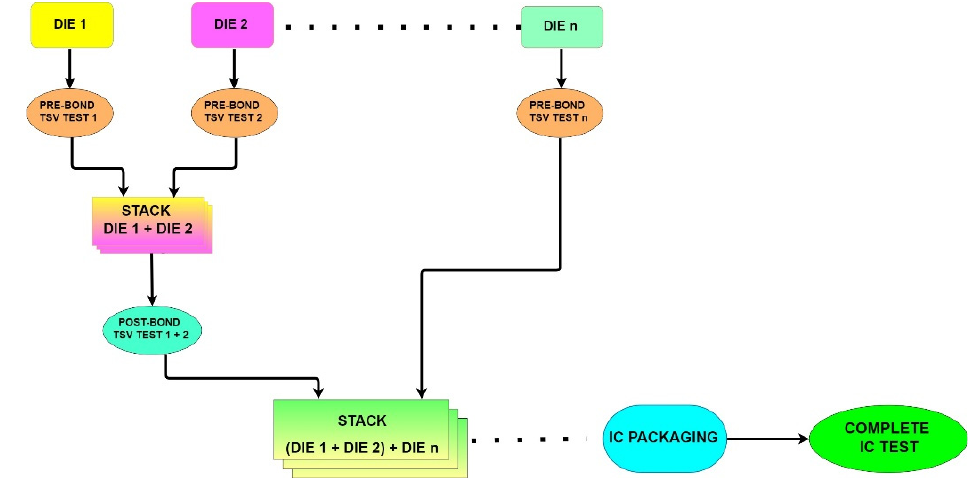
Figure 1. Basic flow diagram for a 3D-stacked IC testing.